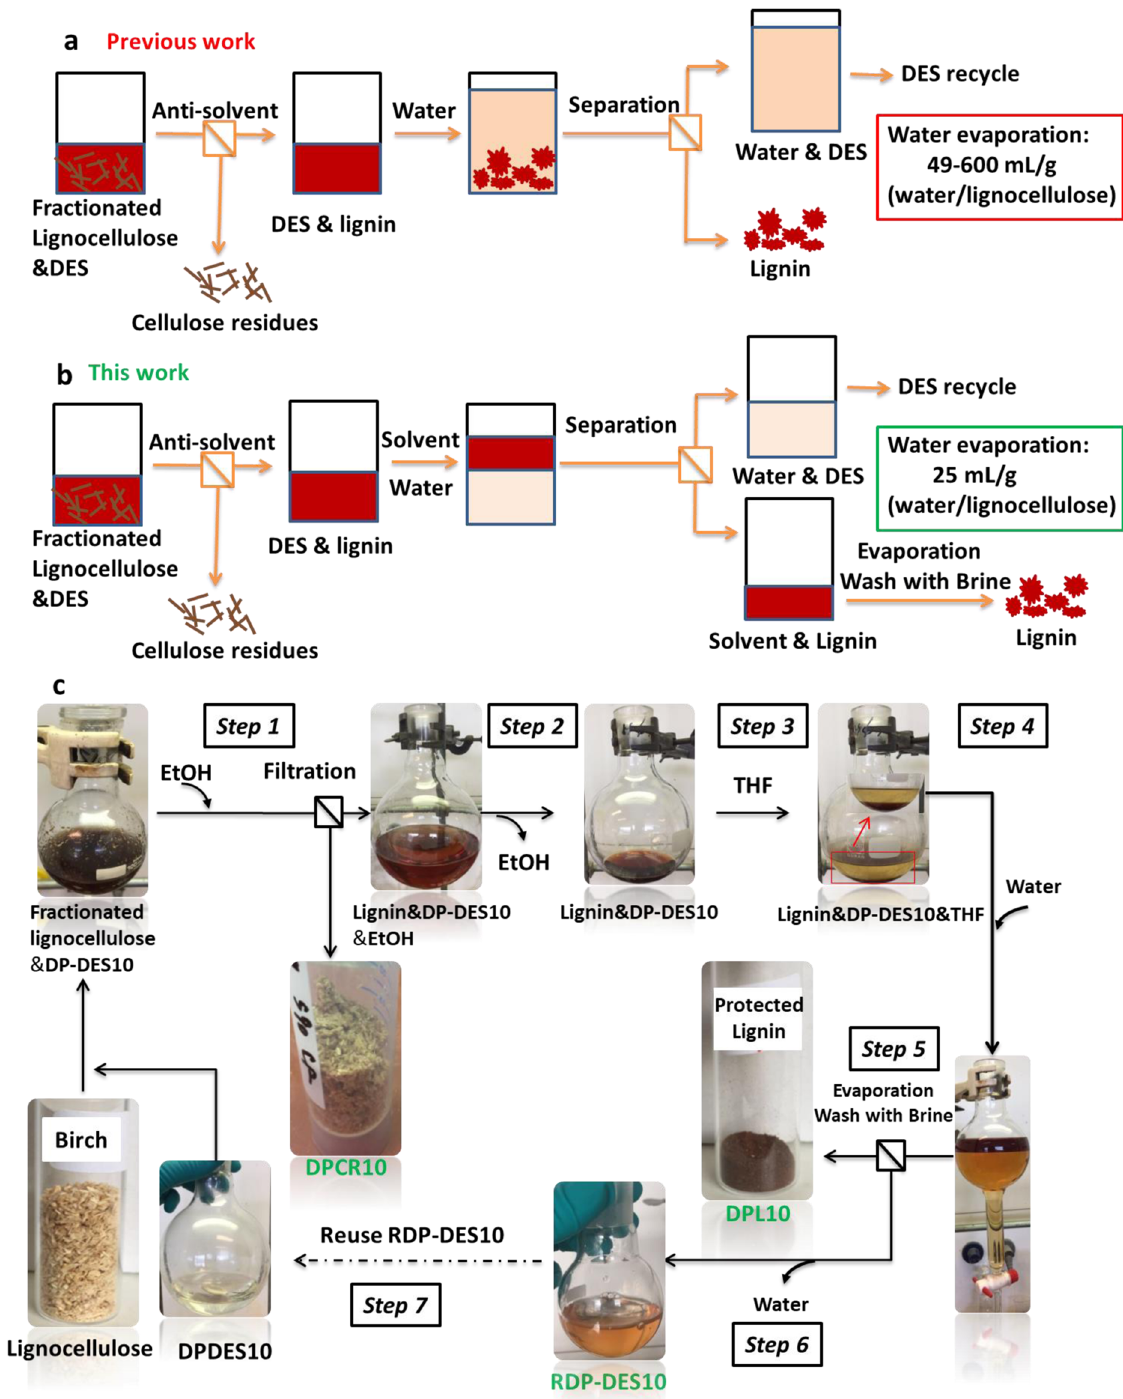
Fig. 5 Lignocellulose fractionation and lignin isolation protocol in DP-DES. a Traditional lignin isolation method from DES. Typically, after the separation of cellulose, lignin is precipitated from DES by the addition of water followed by fi ltration or centrifugation/decantation, and the DES is recovered by water removal. b The lignin isolation method is based on liquid/liquid extraction from DES. After adding organic solvent and a small amount of water, lignin is selectively extracted from a concentrated ionic aqueous DES solution and is subsequently recovered after evaporating the organic solvent. High purity DES is recycled by water removal. c Systematic birch lignocellulose fractionation protocol in DP-DES10 (ChCl, 120 mmol, 16.8 g: EG, 240 mmol, 14.4 g: 10 wt% OA, 25 mmol, 3.2 g) by steps. Carbohydrate-rich residues are isolated using ethanol as an anti-solvent after fi ltration (Step 1). Ethanol is evaporated to obtain a lignin/DES mixture (Step 2). Upon addition of THF as well as water, a brown-colored THF phase containing lignin is clearly separated from the aqueous phase containing DES. The lignin is isolated by extraction of an aqueous DES phase with THF (Steps 3 and 4). DPL10 was obtained as powder after solvent removal and precipitated in brine (Step 5). DP-DES10 is recycled by removal of water by distillation (Step 6). The recycled DP-DES10 was characterized by yield (mass percentage to original DP-DES10) and purity (Supplementary Note 6.1.3) and reused for a second run (Step